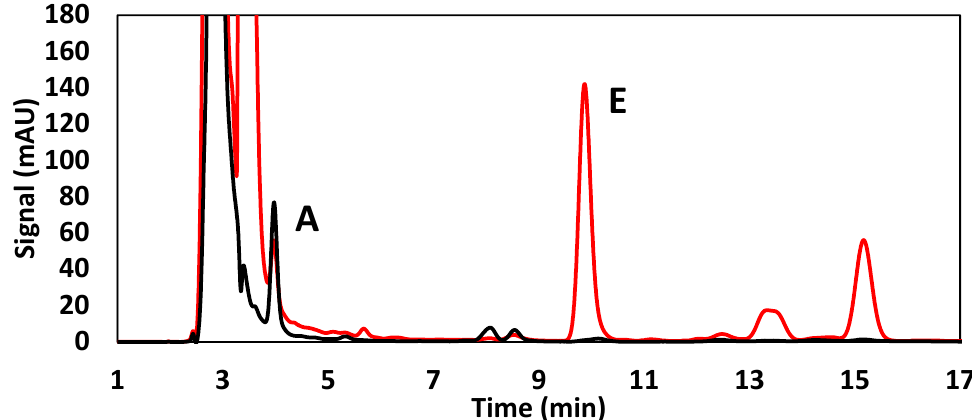
Figure 4. Chromatographic separation of vitamin A and E through high-performance liquid chromatographic coupled to